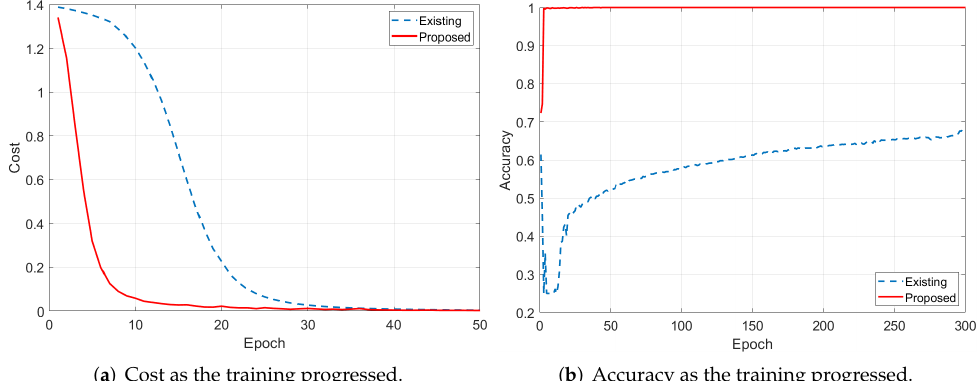
Figure 13. Performance analysis of the effectiveness of the proposed